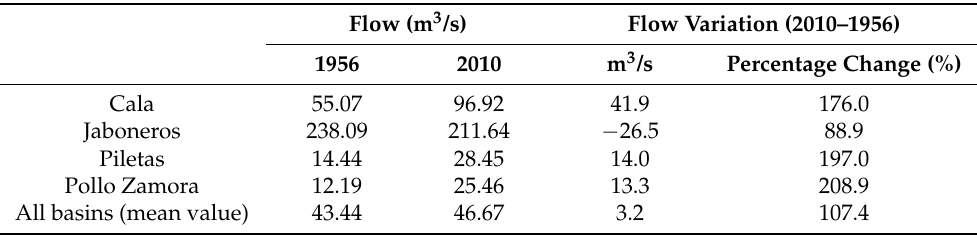
Table 6. Maximum instantaneous flow in each basin in 1956 (500-year return period) and flow variation compared to